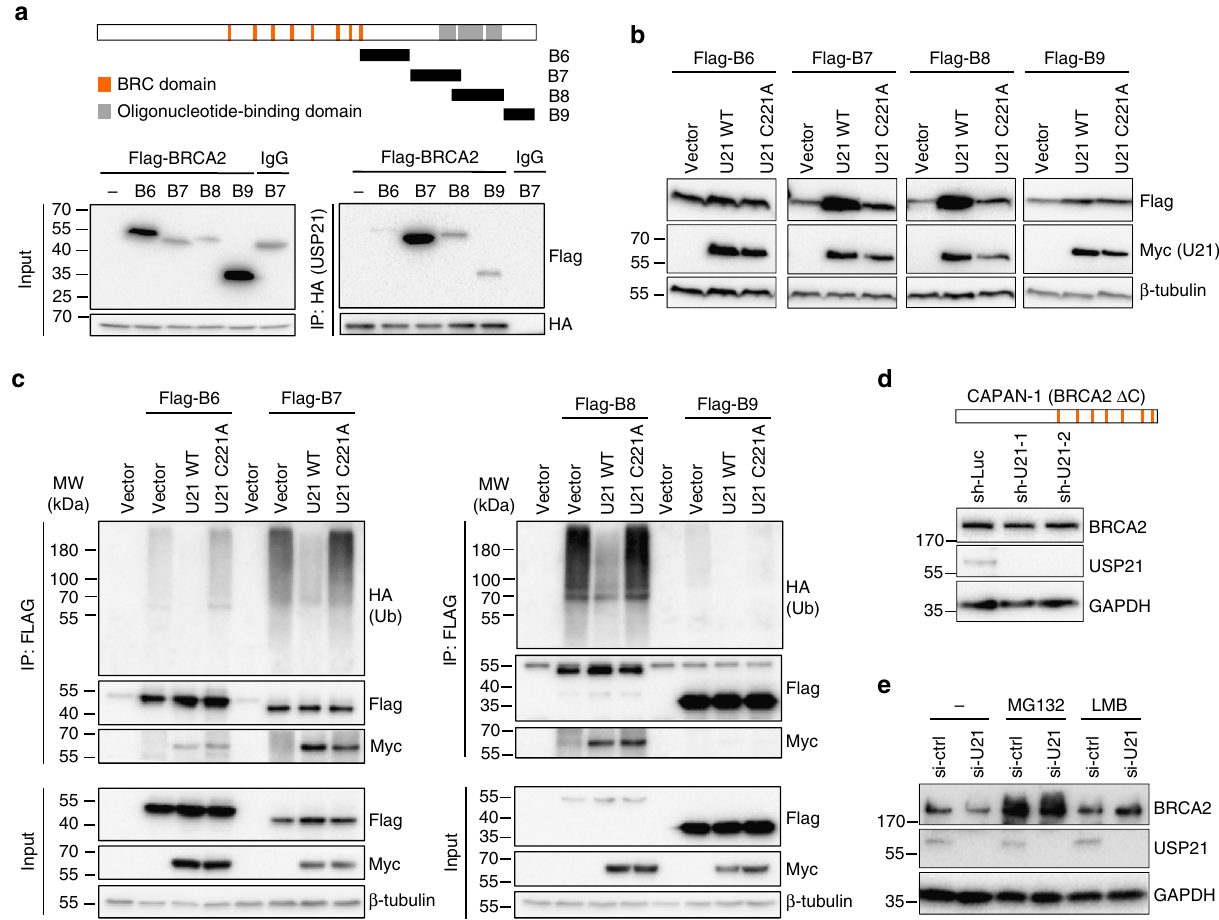
Fig. 3 USP21 deubiquitinates and stabilizes BRCA2 via its C-terminus. a IP using anti-HA conjugated beads in HEK293T cells expressing HA-USP21 and the indicated Flag-BRCA2 fragments. A schematic of full-length BRCA2 and BRCA2 C-terminal fragments is shown. b Western blot analysis of the indicated BRCA2 fragments in the presence of empty vector, Myc-USP21 WT (U21 WT), or the Myc-USP21 C221A catalytic mutant (U21 C221A). c Ubiquitination assay in cells expressing HA-Ub and the indicated Flag-BRCA2 fragments in the presence of empty vector (V), U21 WT or U21 C221A. Cells were treated with MG-132 prior to Flag-IP. d BRCA2 western blot analysis in CAPAN-1 cells in the presence or absence of USP21 knockdown. A schematic for